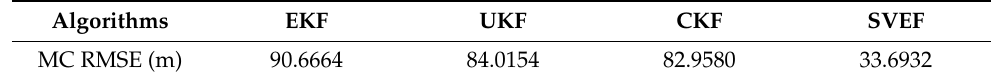
Table 3. MC RMSE for different